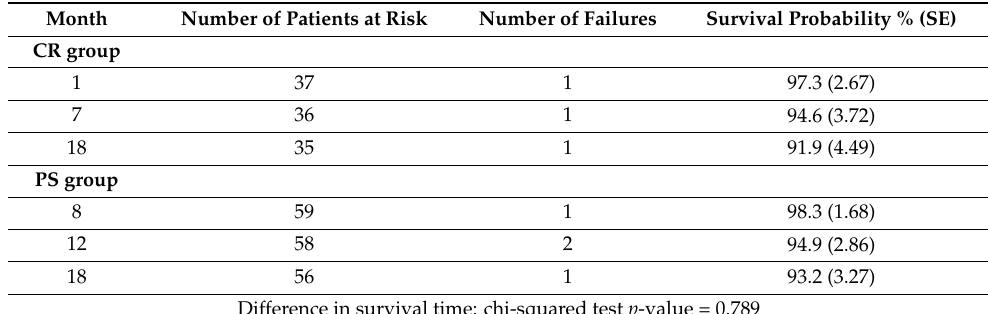
Table 4. Analysis of survival in each study